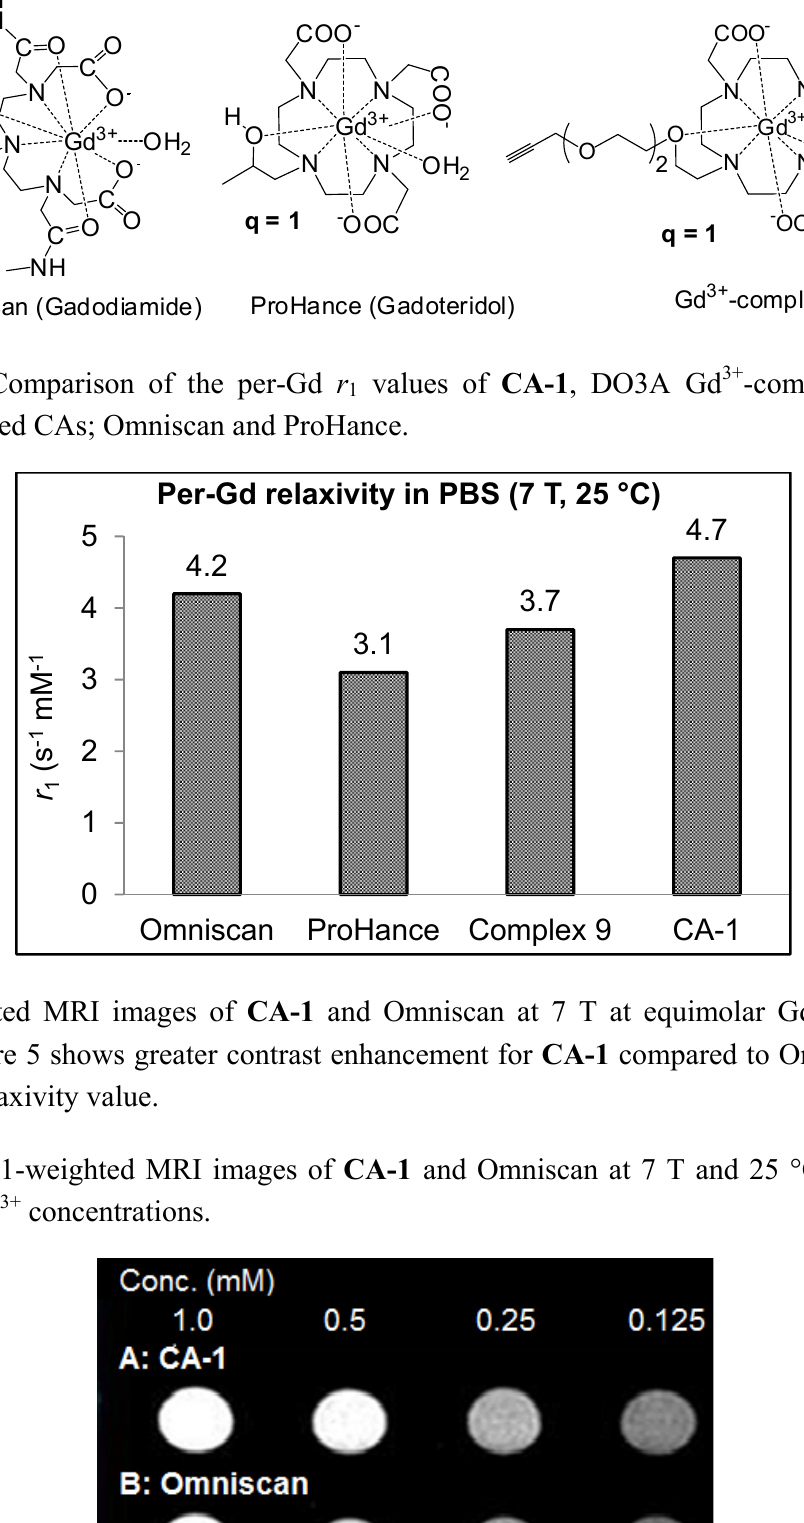
Figure 3. Structures of clinically used MRI CAs; Omniscan and ProHance and Gd 3+ -complex 9 .